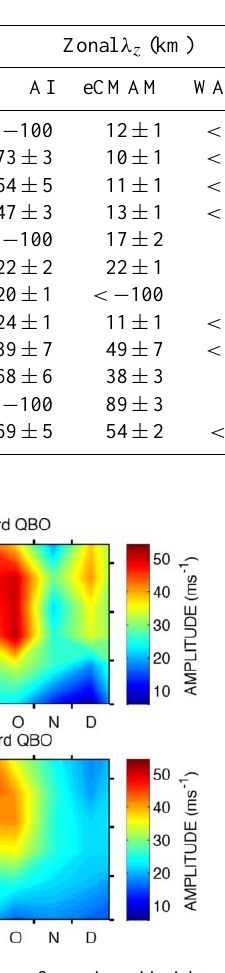
Fig. 12. Diurnal tidal amplitudes as a function of month and height for eastward (upper) and westward (lower) QBO phase defined at